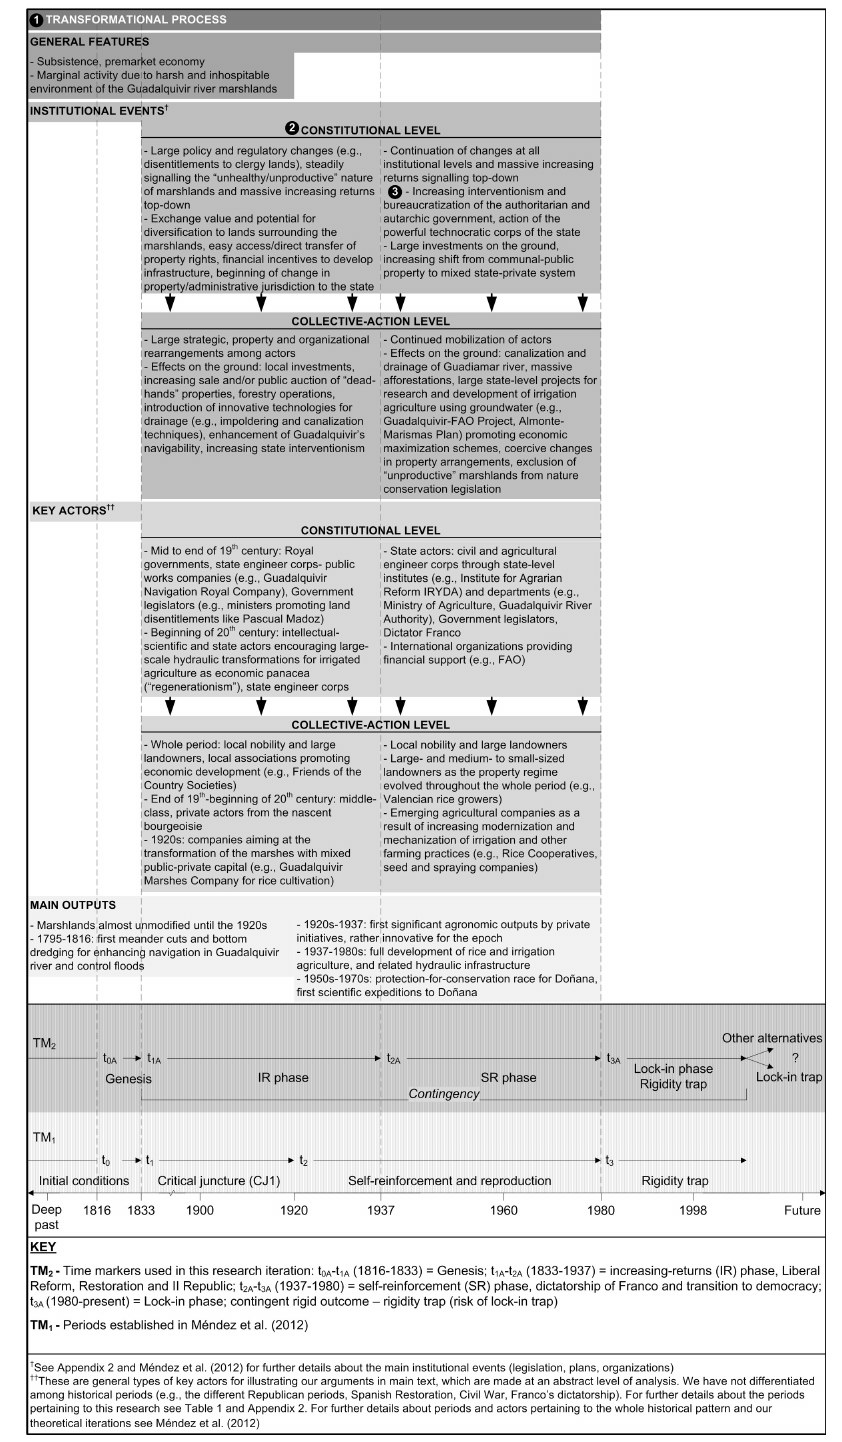
Fig. 5 . Synthesis of Méndez et al. (2012) historical explanatory pattern, including information about key institutional events, actors, and transformations on the ground. TM et al. (2012); TM specifies the time markers resulting from the explanatory refinement presented here, based on 2 the definition of path dependence of Vergne and Durand (2010). IR = increasing returns; SR = self-